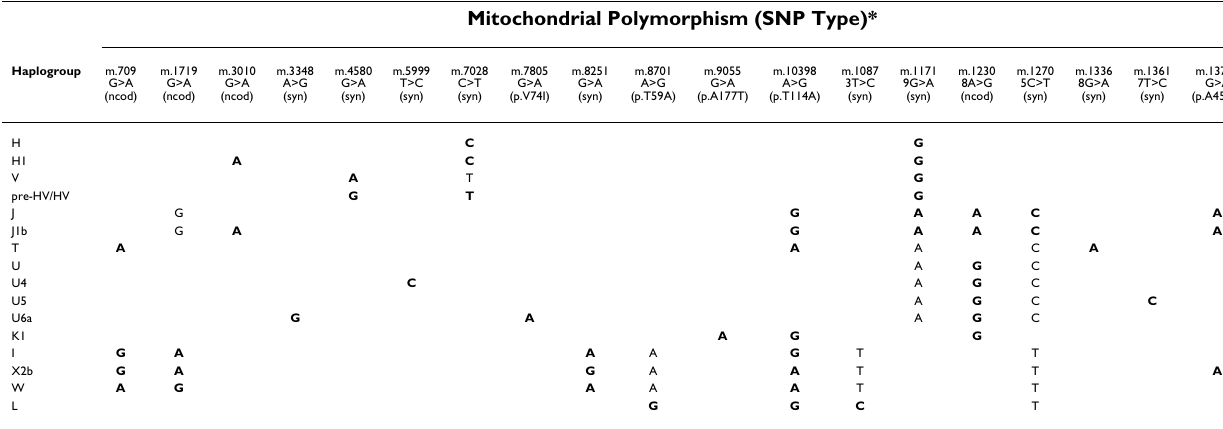
Table 1: Type of investigated mitochondrial markers and haplogroup determination.